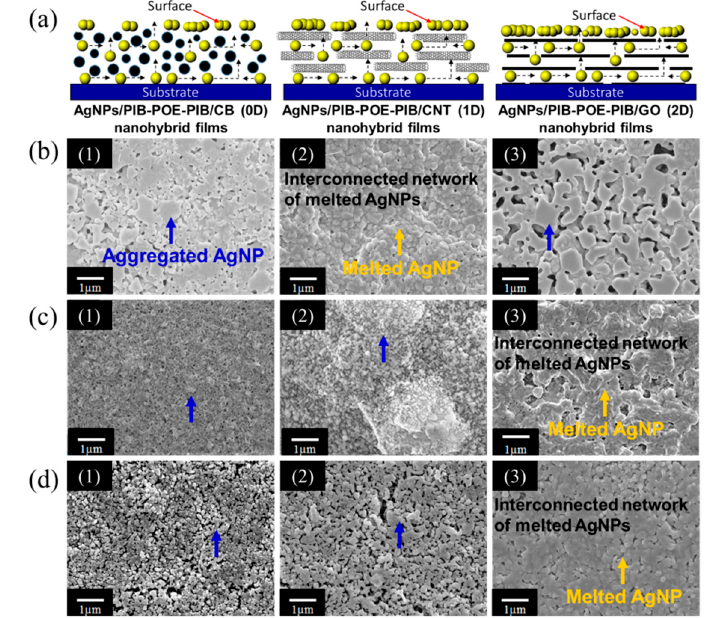
Figure 5. ( a ) Schematic diagram showing the migration of AgNPs to the film surface with the three AgNPs / PIB-POE-PIB / carbon-based nanomaterial hybrids. (1) AgNPs / PIB-POE-PIB / CB, (2) AgNPs / PIB-POE-PIB / CNT, and (3) AgNPs / PIB-POE-PIB / GO. FE-SEM image during the melting of AgNPs on the surfaces of the flexible polyimide substrates. Formation of whitish thin films and conductivity value can be analyzed using the FE-SEM images taken when AgNPs / PIB-POE-PIB / carbon-based nanomaterials thin films with di ff erent weight ratios were heated